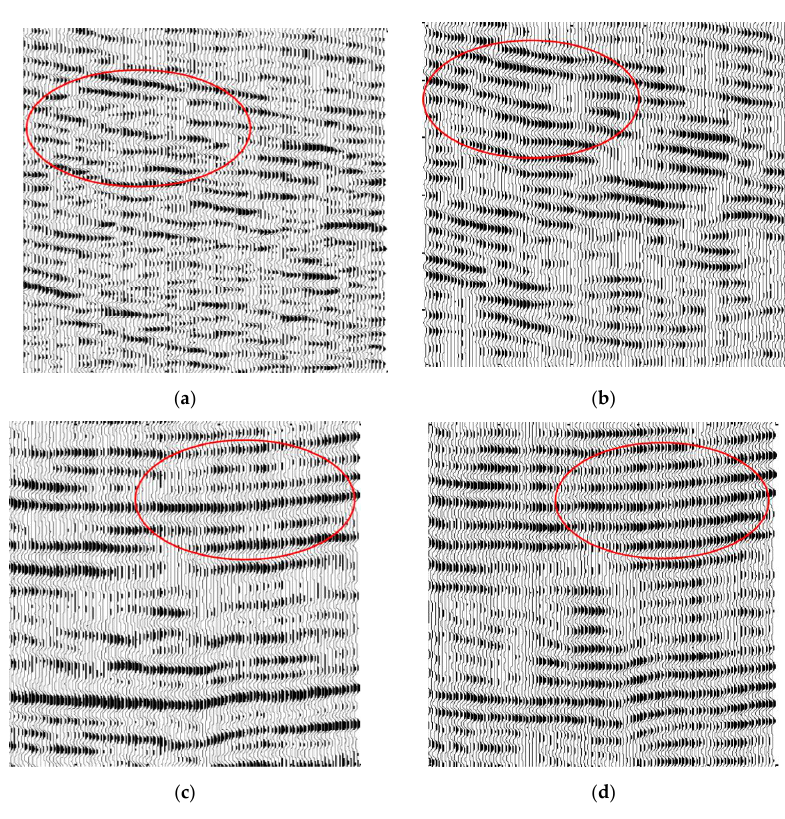
Figure 13. Actual seismic data processing; ( a ) actual seismic profile; ( b ) profile 1 processed by this method; ( c ) actual seismic profile; ( d ) profile 2 processed by this method. method; ( c ) actual seismic profile; ( d ) profile 2 processed by this